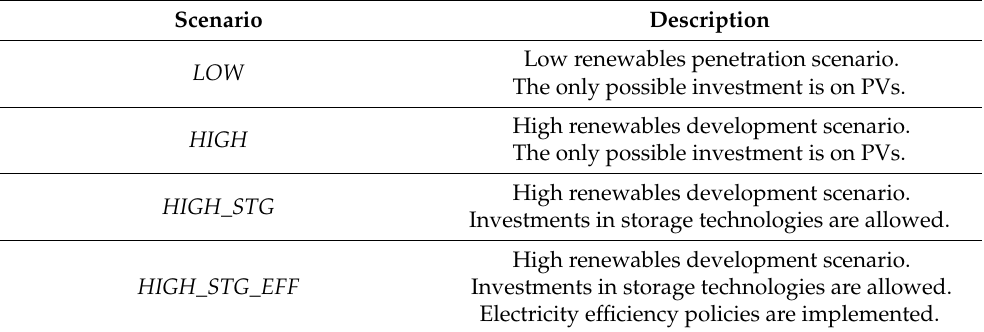
Table 3. Summary of the scenarios considered for analysis. Scenario Description Low renewables penetration scenario. LOW The only possible investment is on PVs. High renewables development scenario. HIGH The only possible investment is on PVs. High renewables development scenario. HIGH_STG Investments in storage technologies are allowed.